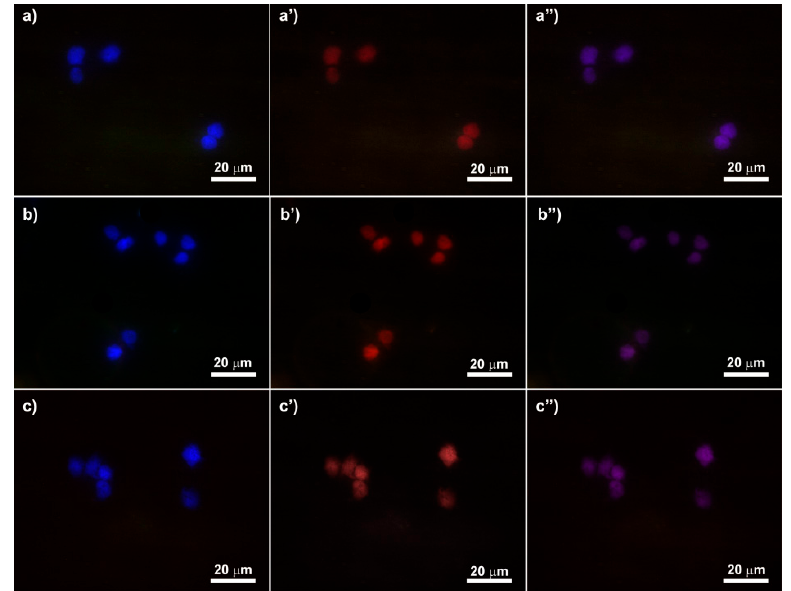
Figure 6. Fluorescence micrographs of the selected fraction of CDs 18.5bar ( a – a’’ ), CDs 13bar ( b–b’’ ) and CDs 8bar ( c – c’’ ) after 6 h of incubation on MDA-MB-231. Magnification 40 ×: nucel (blue; a , b and c ), CDs (red; a,’ b’ and c’ ) and merge ( a’,’ b’’ and c’’ ).